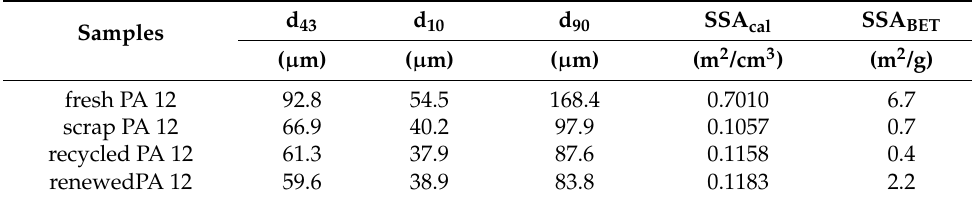
Table 1. Particle size (d 43 , d 10 , and d 90 ) and specific surface area (SSA BET , SSAcal) of experimental samples.